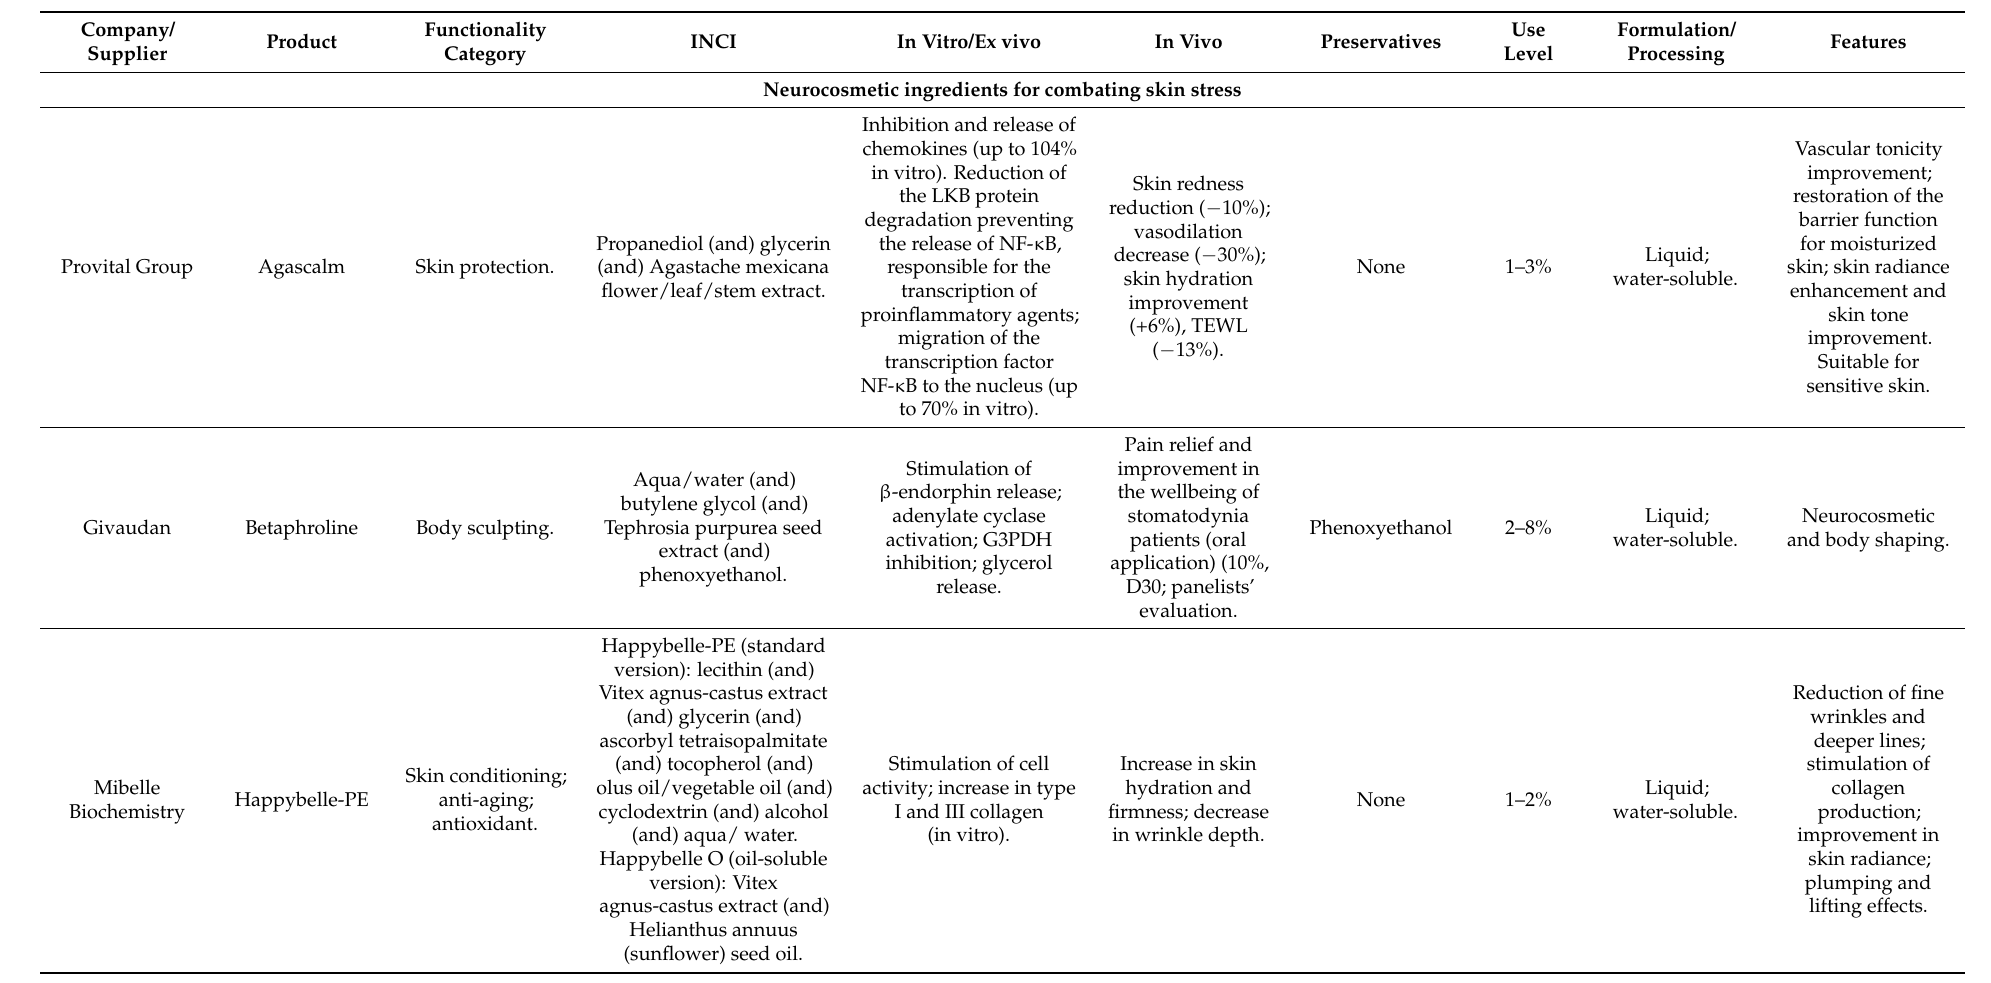
Table 1. Neurocosmetic ingredients on the market 1